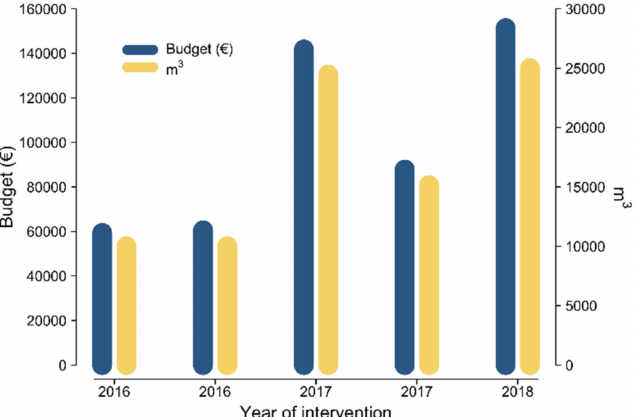
Figure 3. Guadiaro river mouth artificial openings from 2016 to 2018. Sand extraction volume (m 3 ) and budget involved from the Spanish Government. There was no intervention during 2019 and